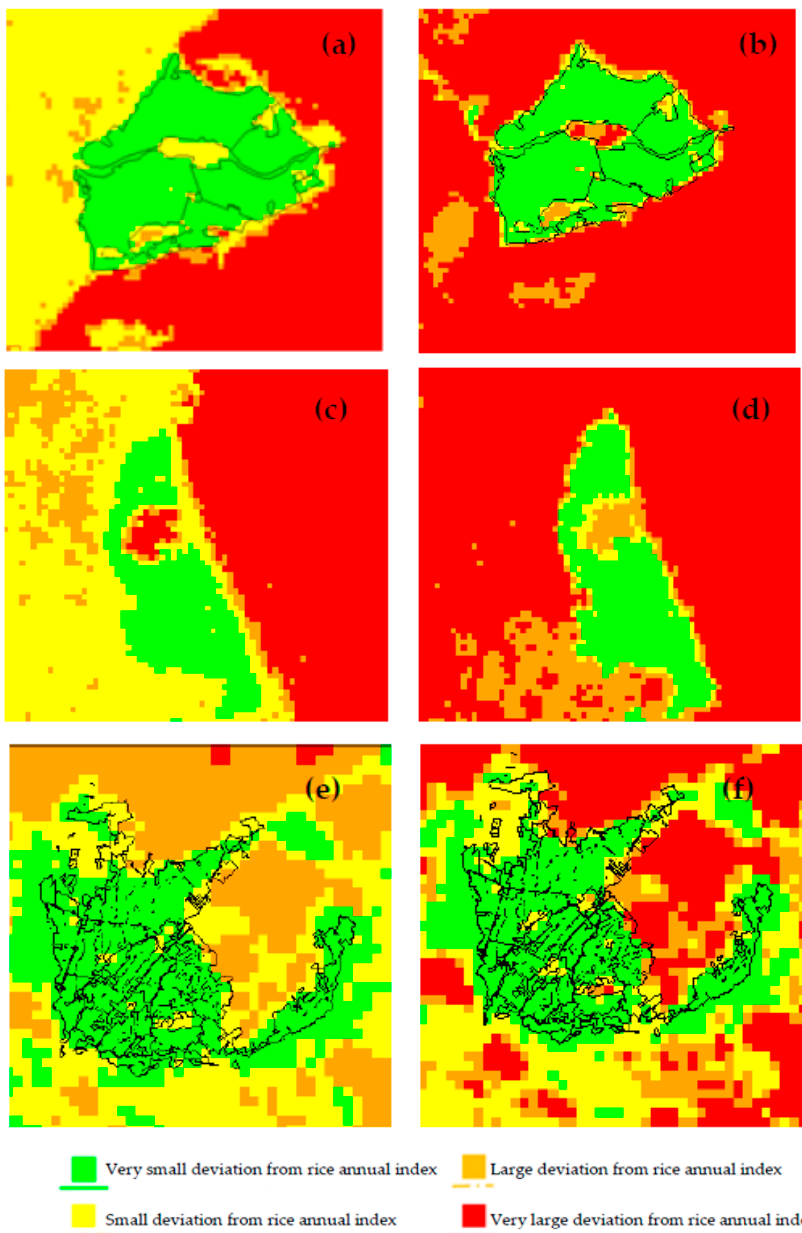
Figure 5. Rice field maps based on NDVI (left) and SASI (right) annual patterns in the study sites: Ebro Delta ( a , b ), Albufera National Park ( c , d ) and Orellana ( e , f ). The rice mask is represented by the black polygons.